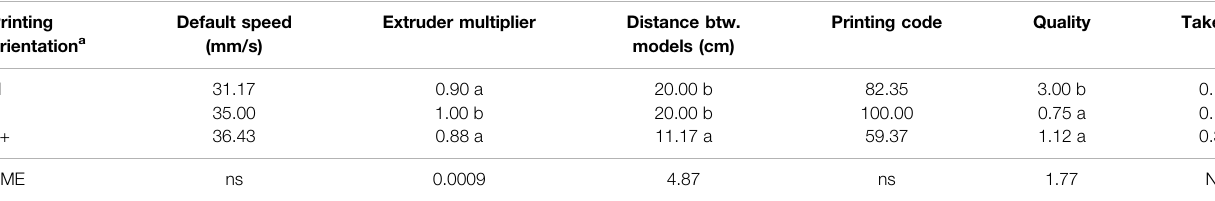
TABLE 5 | PEEK printing parameters and results of the tibiae plug printed at different